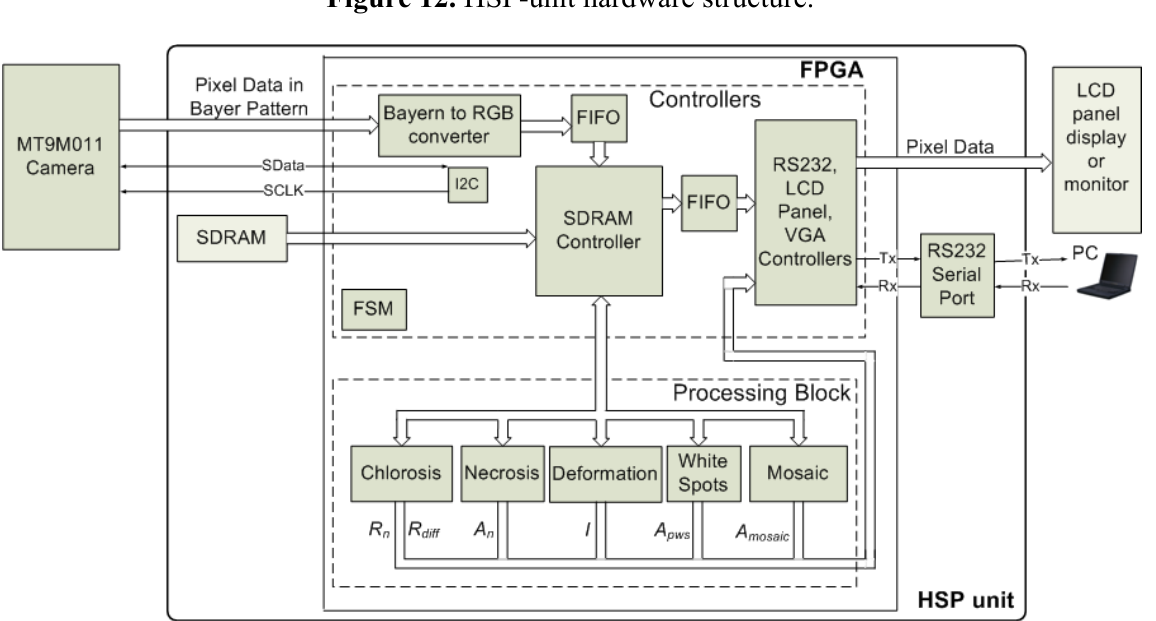
Figure 12. HSP-unit hardware